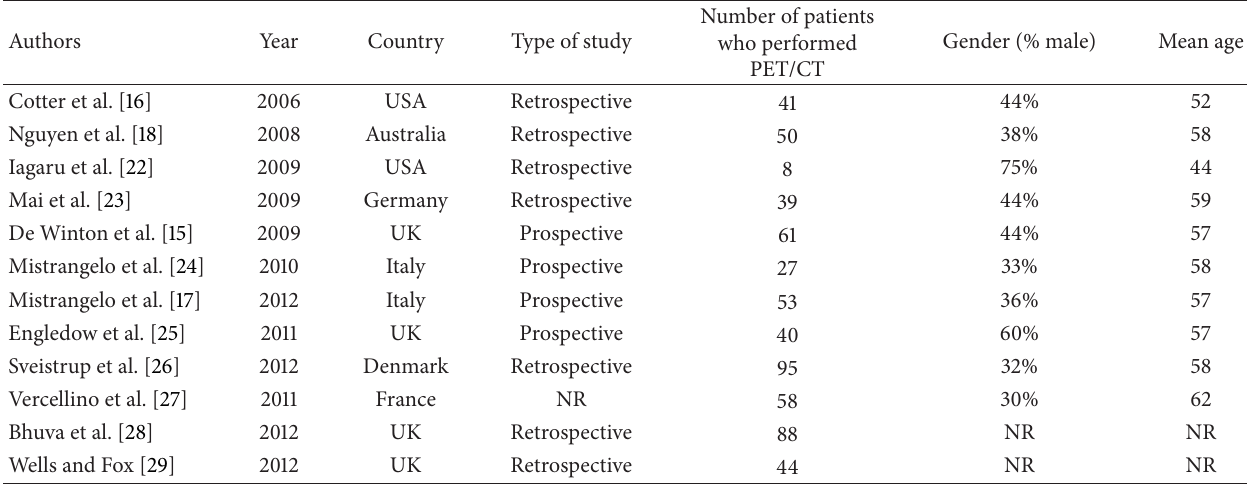
Table 1: Basic characteristics of 12 selected